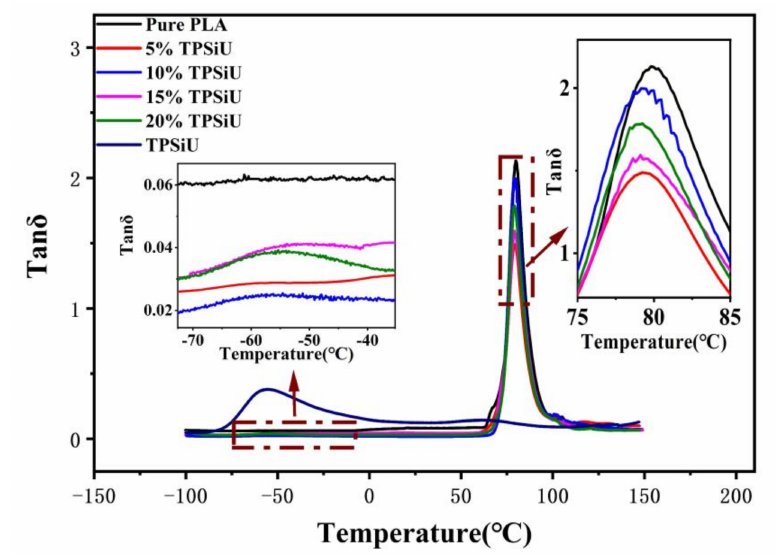
Figure 8. Temperature dependence of tan δ for PLA/TPSiU